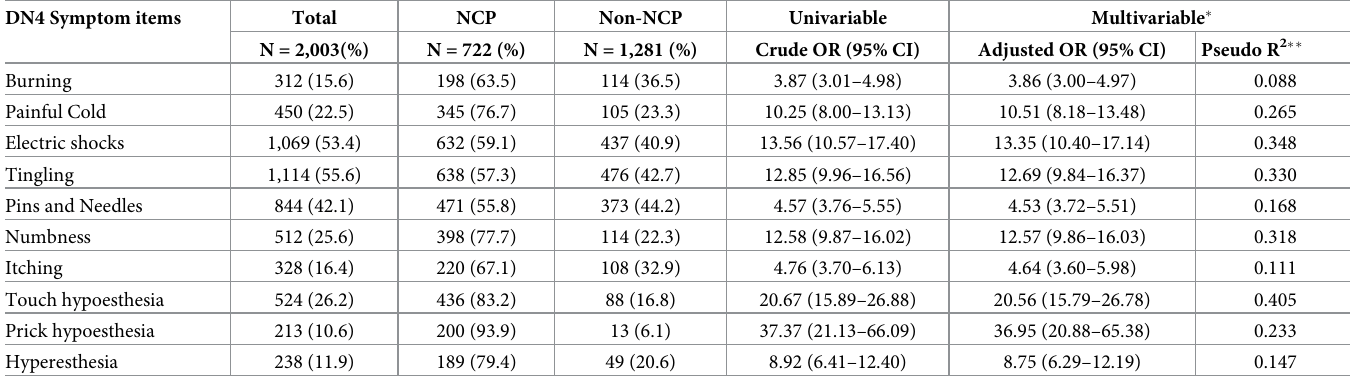
Table 3. Differences in selecting symptom items of the DN4 questionnaire between the NCP (N = 722) and non-NCP (N = 1,281)